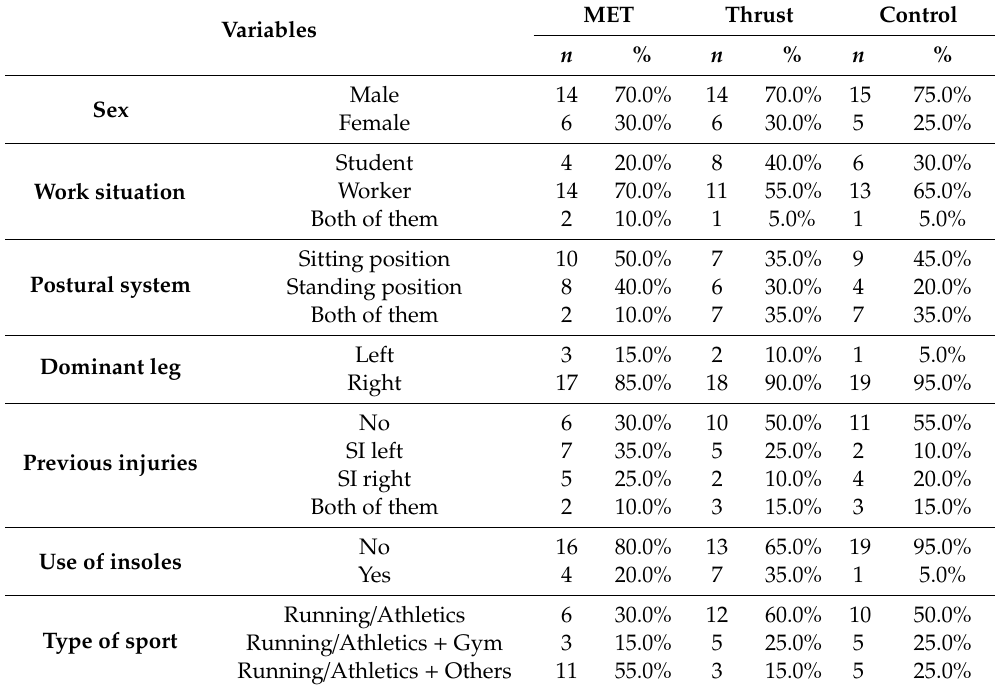
Table 2. Descriptive table of categorical variables per